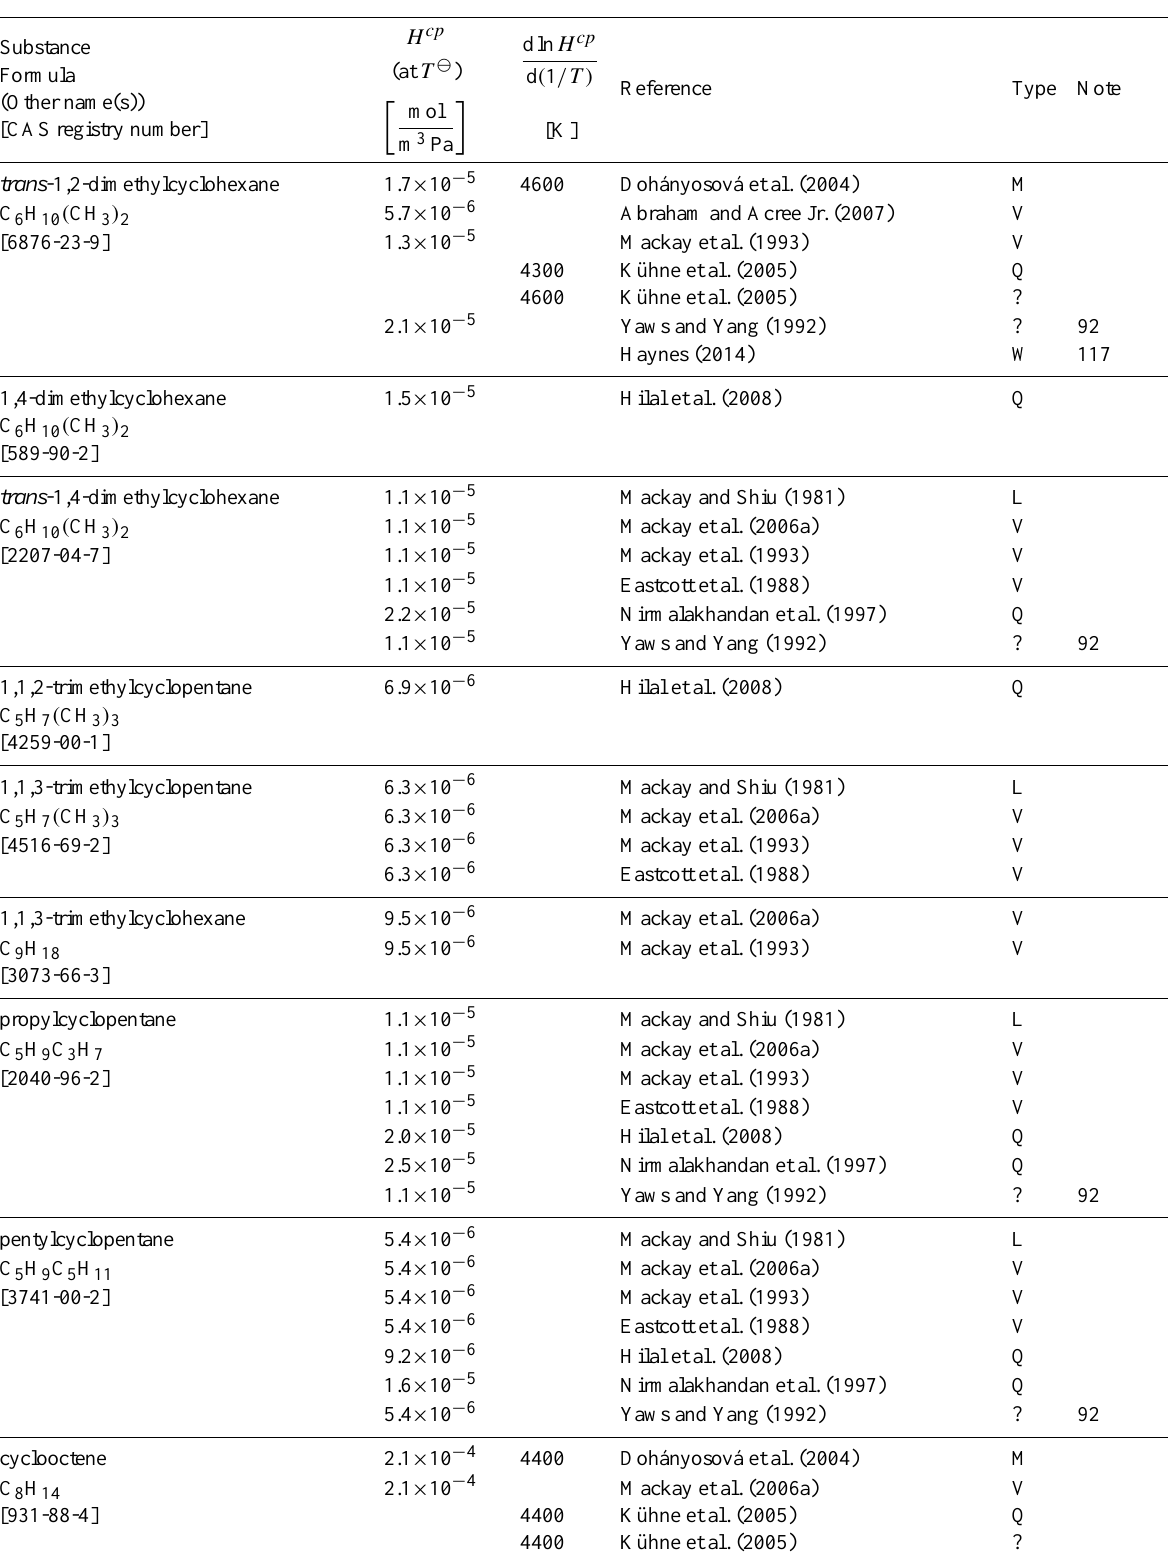
Table 6: Henry’s law constants for water as solvent